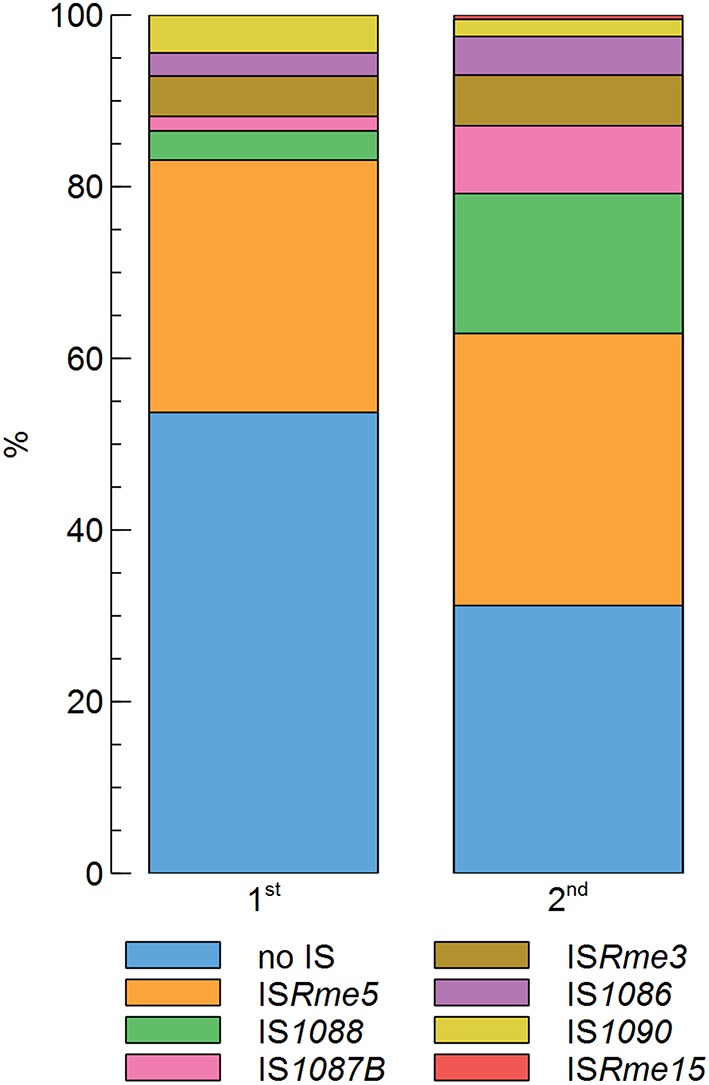
Contribution of different types of cnrYX mutations in the first and second population of zinc-resistant C. metallidurans AE126 derivatives comprising 296 and 202 mutants, respectively.